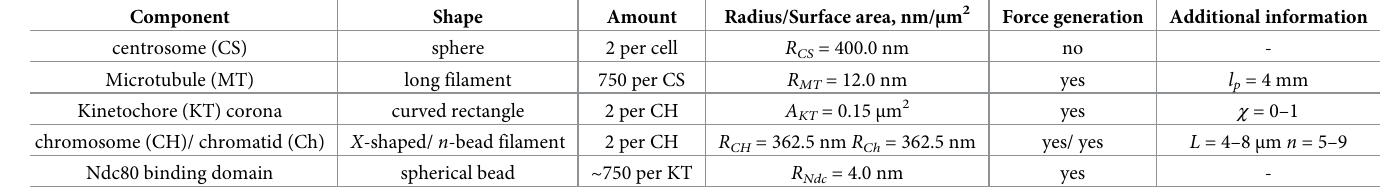
Table 1. Components of CellDynaMo described with Langevin Dynamics approach. Size, shape, and number of each component described using the Langevin Dynamics description of stochastic processes, including centrosomes (CS), microtubules (MTs), kinetochore (KT) corona, chromosomes (CH), and Ndc80 binding domains (Fig 1). Also provided is the information about force-generating properties, number of particles (spherical beads) used to describe each component, and some additional information such as MT persistence length l , surface curvature of the KT corona χ , number of beads per chromatid n , and contour length of a chromatid L . p